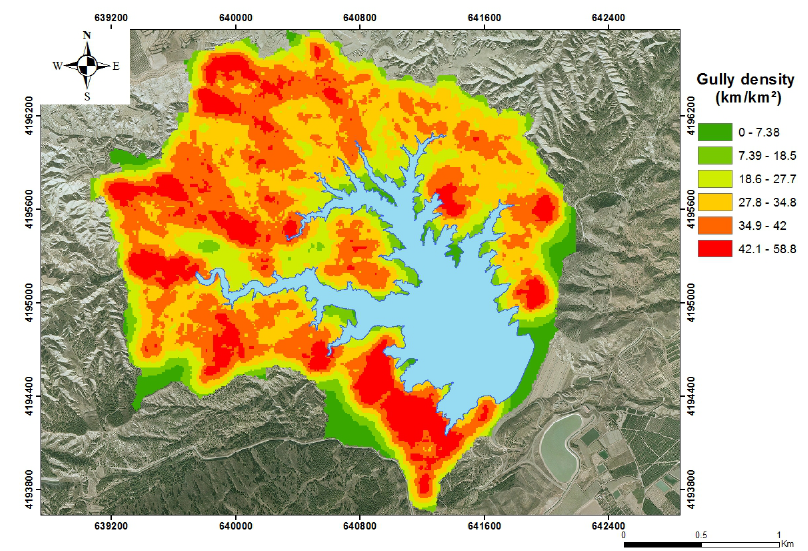
Figure 16. Bank gullies